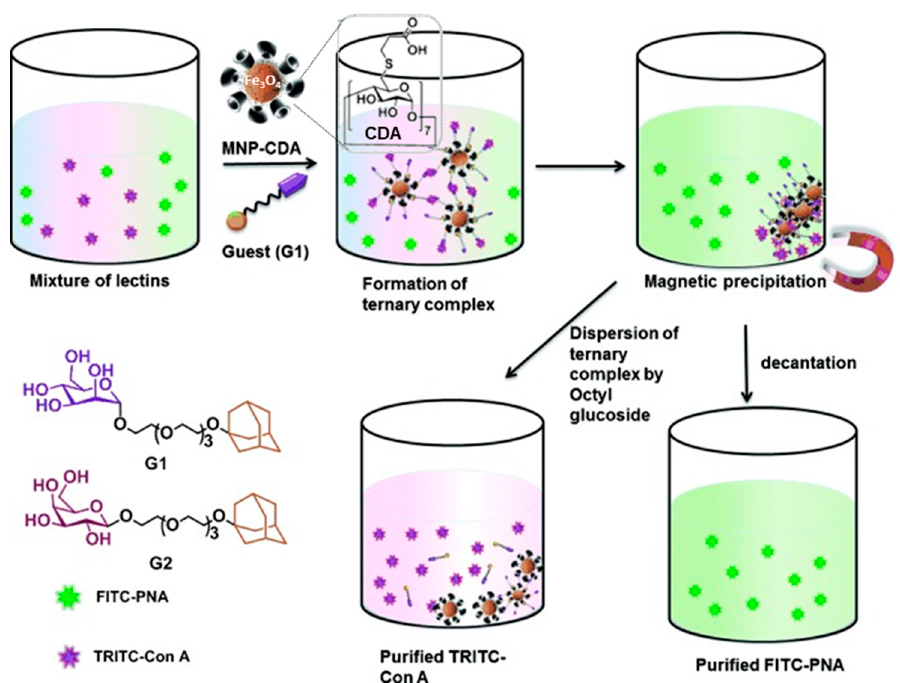
Figure 21. Illustration of the method for separation of proteins reported by Samanta and Ravoo [188] using the cross-linking and magnetic precipitation of magnetic nanoparticles modified with cyclodextrin-acid derivatives (MNP-CDA) and adamantane-armed glycoligands (G1 and G2). Reprinted with permission from Reference [188]. Copyright 2014 WILEY-VCH. FITC-PNA, fluorescein isothiocyanate-labelled peanut agglutinin; TRITC-ConA, tetramethylrhodamine-labelled concanavalin A.